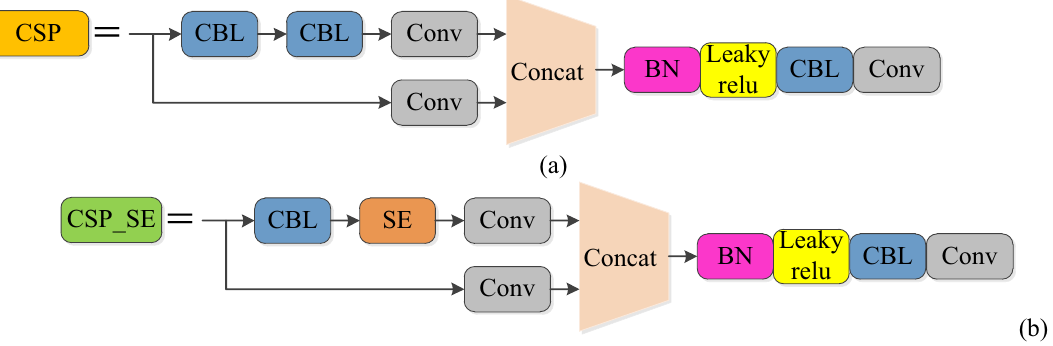
Figure 3. Comparison between CSP model and CSP_SE model. ( a ) CSP model, ( b ) CSP_SE model.